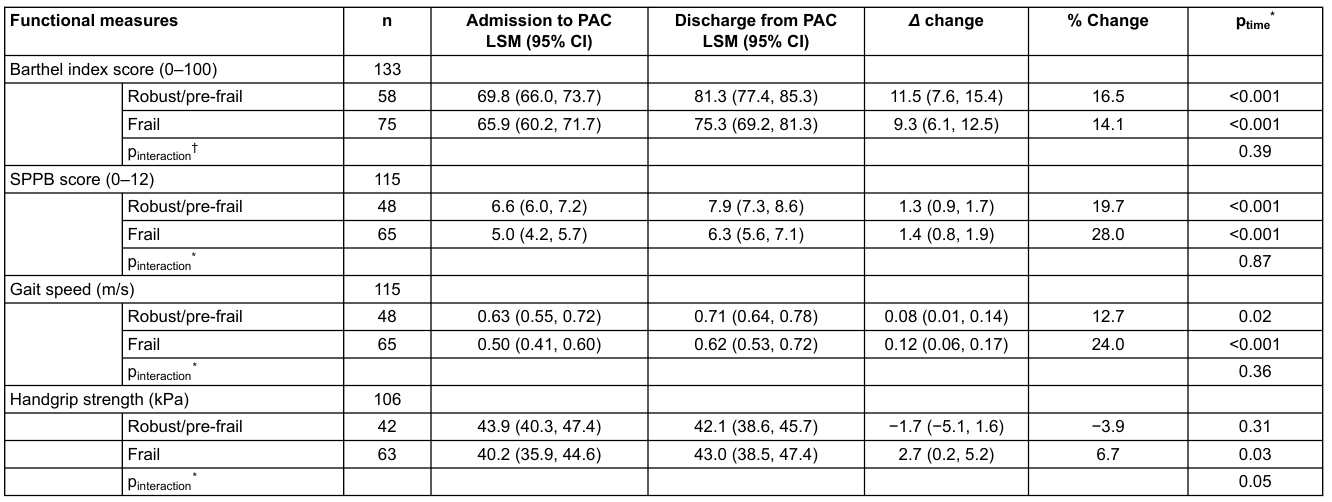
Table 3: Changes in functional measures in frail vs robust/pre-frail participants undergoing post-acute care. Functional